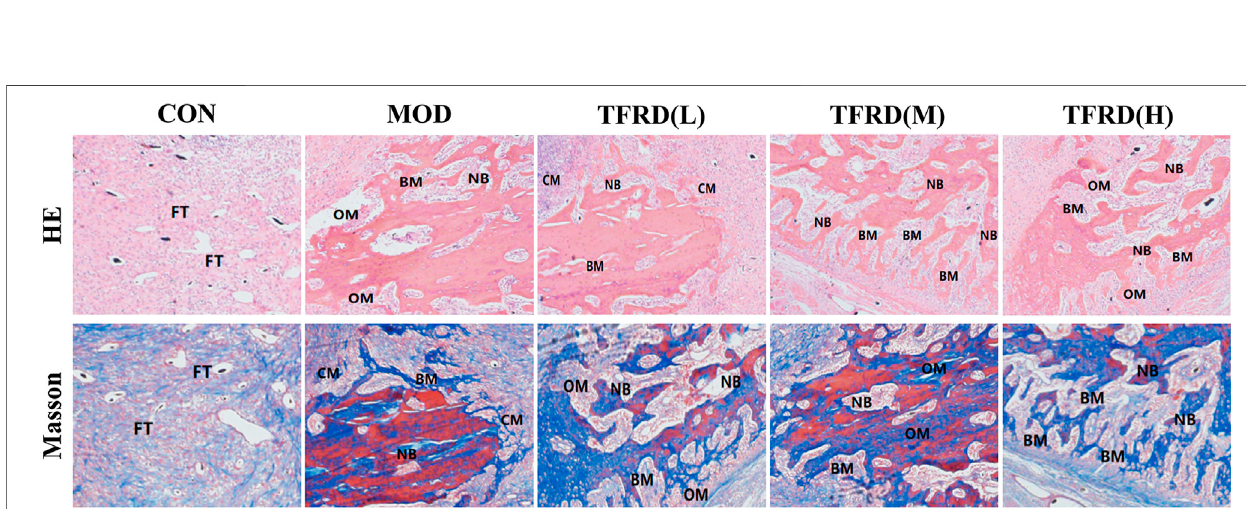
Frontiers in Pharmacology |